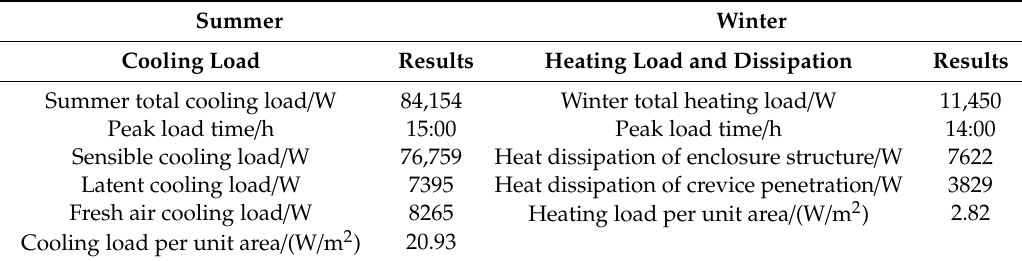
Table 7. Simulated results of thermal load and heat dissipation.